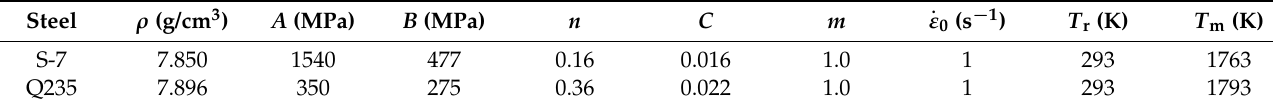
Table 5. Material constants for S-7 and